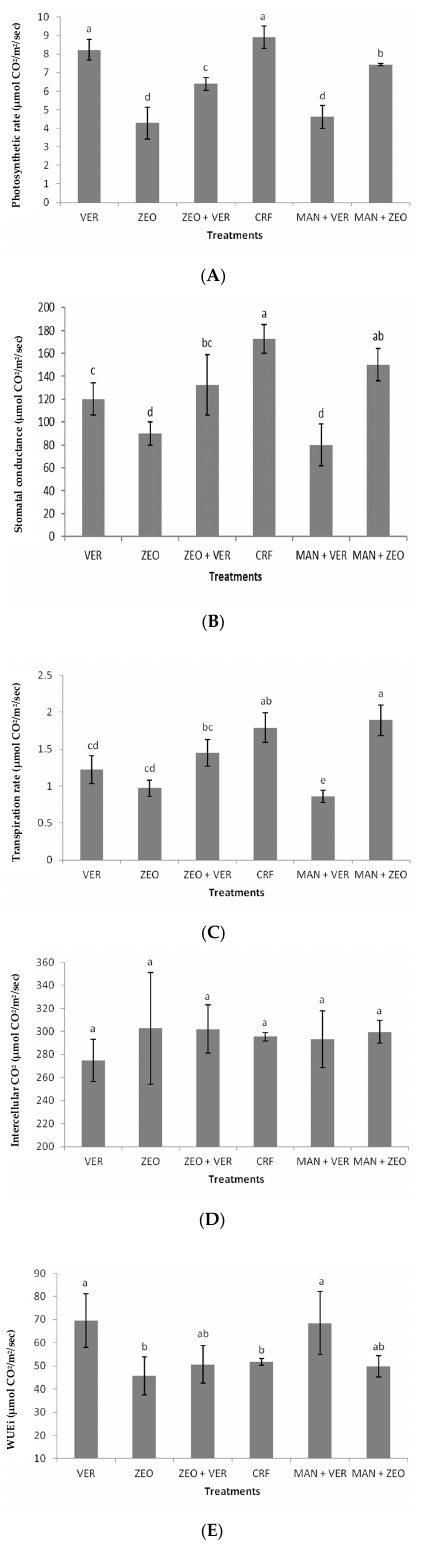
Figure 4. Photosynthetic rate ( A ), stomatal conductance ( B ), transpiration rate ( C ), intercellular CO 2 concentration ( D ) and intrinsic water use efficiency ( E ) of pepper plants among the treatments. The different letters on the bars signify statistically significant differences among the treatments, according to Duncan’s multiple range test, for p ≤ 0.05. VER: vermiculite; ZEO: zeolite; CRF: controlled-release fertilizer; MAN: manure.